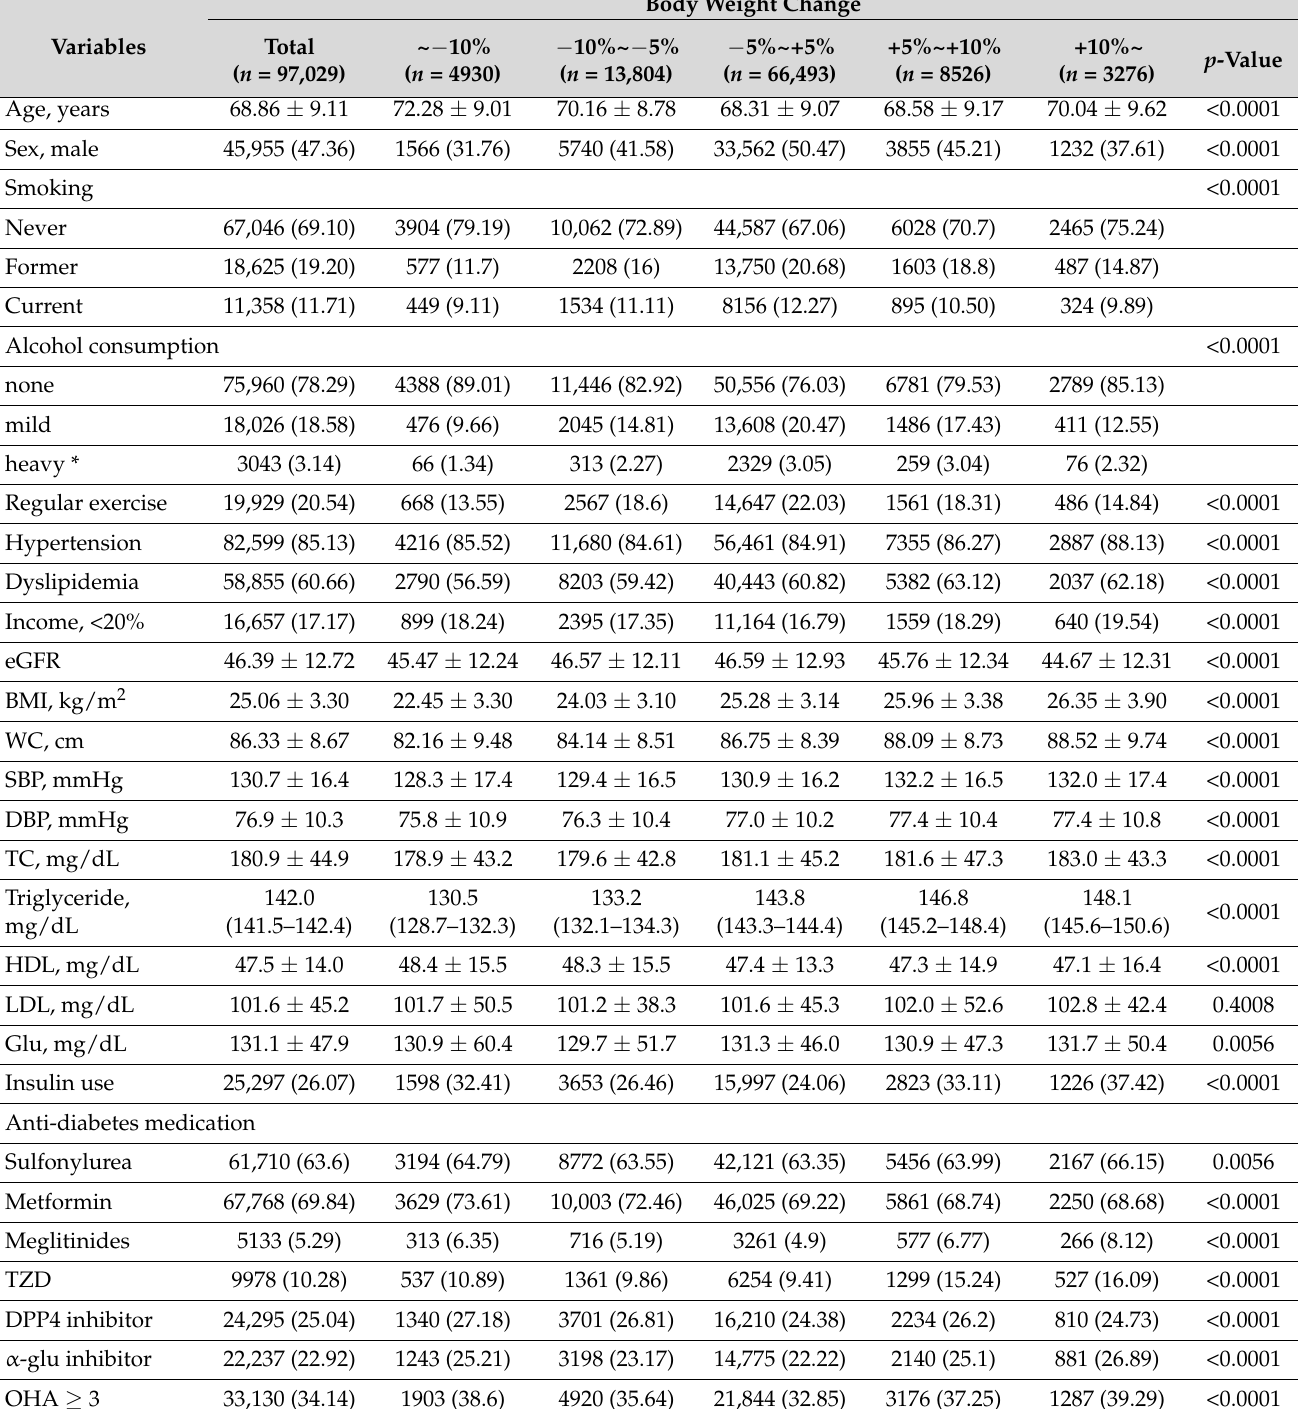
Table 2. Baseline characteristics of patients according to body weight